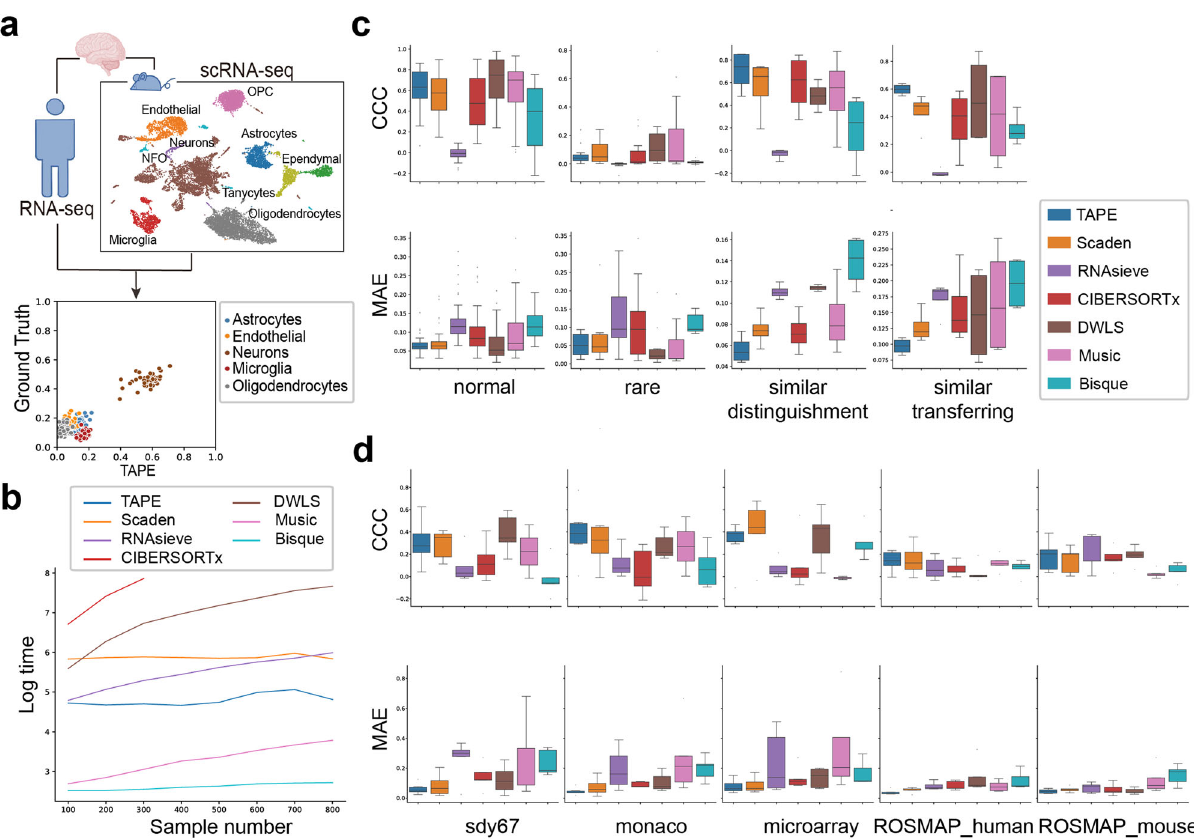
Fig. 2 | Comparison of deconvolution algorithms on benchmark datasets. a Deconvolutionprocedurediagram.BulkRNA-seqdataandsingle-celldatashould come from a homologous tissue. b Time complexity analysis of different methods (including pre-processing steps). Time measured by seconds is scaled by Log ðÞ to show the differences more clearly. These tests are conducted on the simulated data. The time limit is set to 2500s. Any longer test was not conducted. c Deconvolution results on simulated data. CCC represents the Lin ’ s concordance correlationcoef fi cient,measuringtheconcordancebetweenthepredictedfraction andthegroundtruth.MAErepresentsmeanabsoluteerror,measuringtheaccuracy of prediction. Higher CCC and lower MAE are better. Each box contains metric